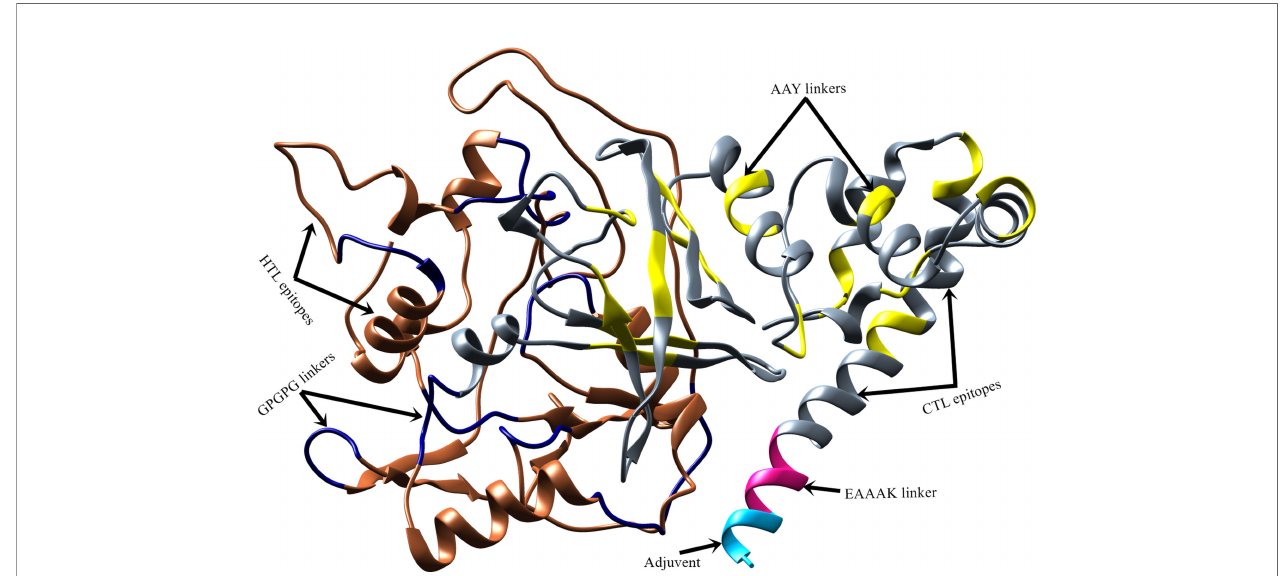
FIGURE 4 | Predicted 3D structure of vaccine construct. Vaccine adjuvant is shown in cyan color, EAAAK linker in pink, CTL epitopes are in grey, AAY linkers and GPGPG linkers are in yellow and navy-blue color, respectively, while HTL epitopes are in sienna